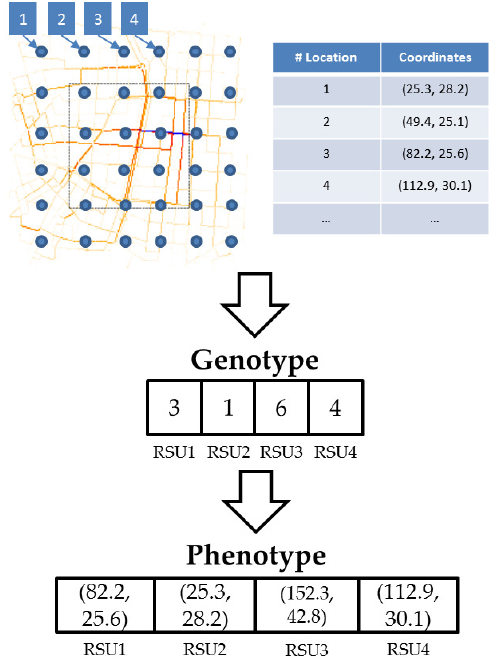
Figure 1. Representation of individuals in the genetic algorithm for roadside unit (RSU) deployment (GARSUD). Each possible location for RSUs appear as blue circles on the map